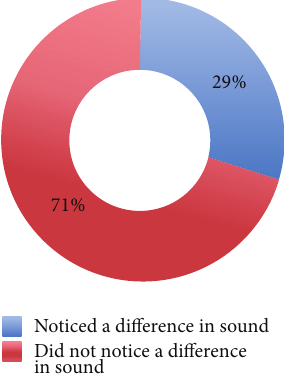
Figure 3: Only 5 out of the 17 test participants (29%) noticed a difference in the